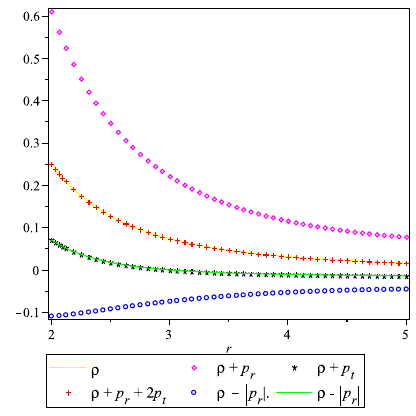
( d ) This figure depicts the behavior of all EC terms for Model-I in Subcase 7 ( ξ 1 = 0, α 1 < 0, β 1 >